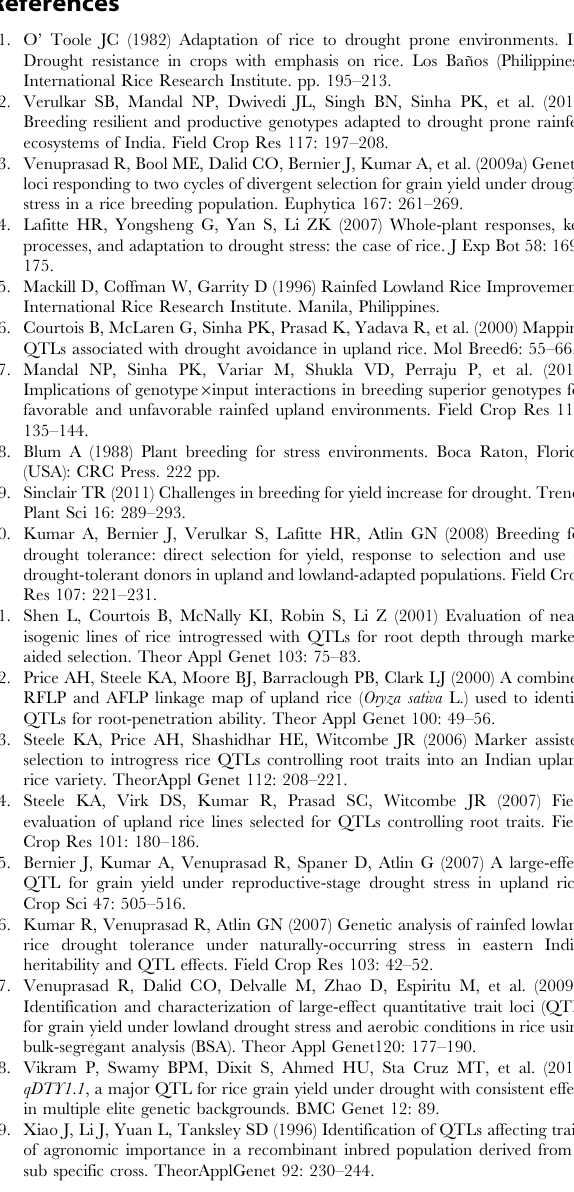
Table S6 Performance of 84 IR64-NILs under non – stress (NS) and drought stress (S) conditions. Table S7 List of candidate genes associated with yield- under-drought QTLs. Table S8 Candidate genes/gene families and their biological functions under stress